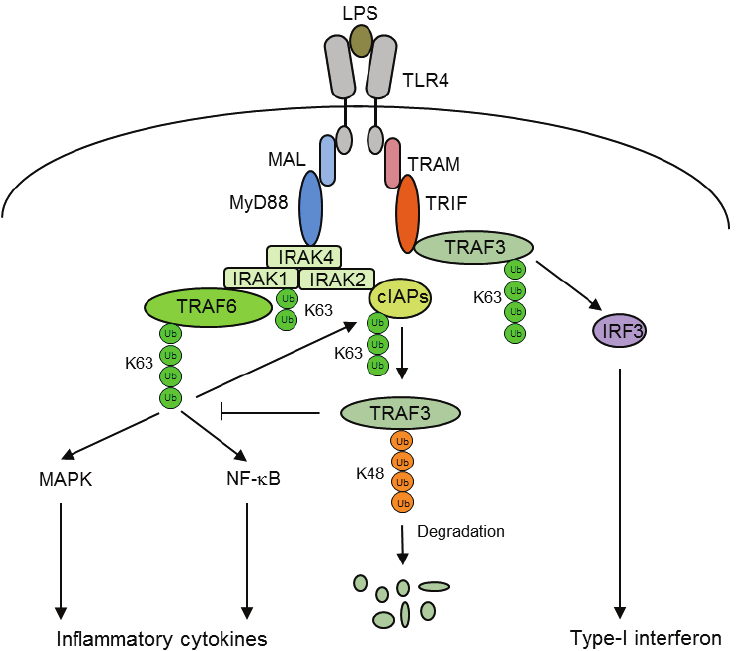
Figure 3. Ubiquitination-mediated signaling cascades in TLR4-induced gene activation.